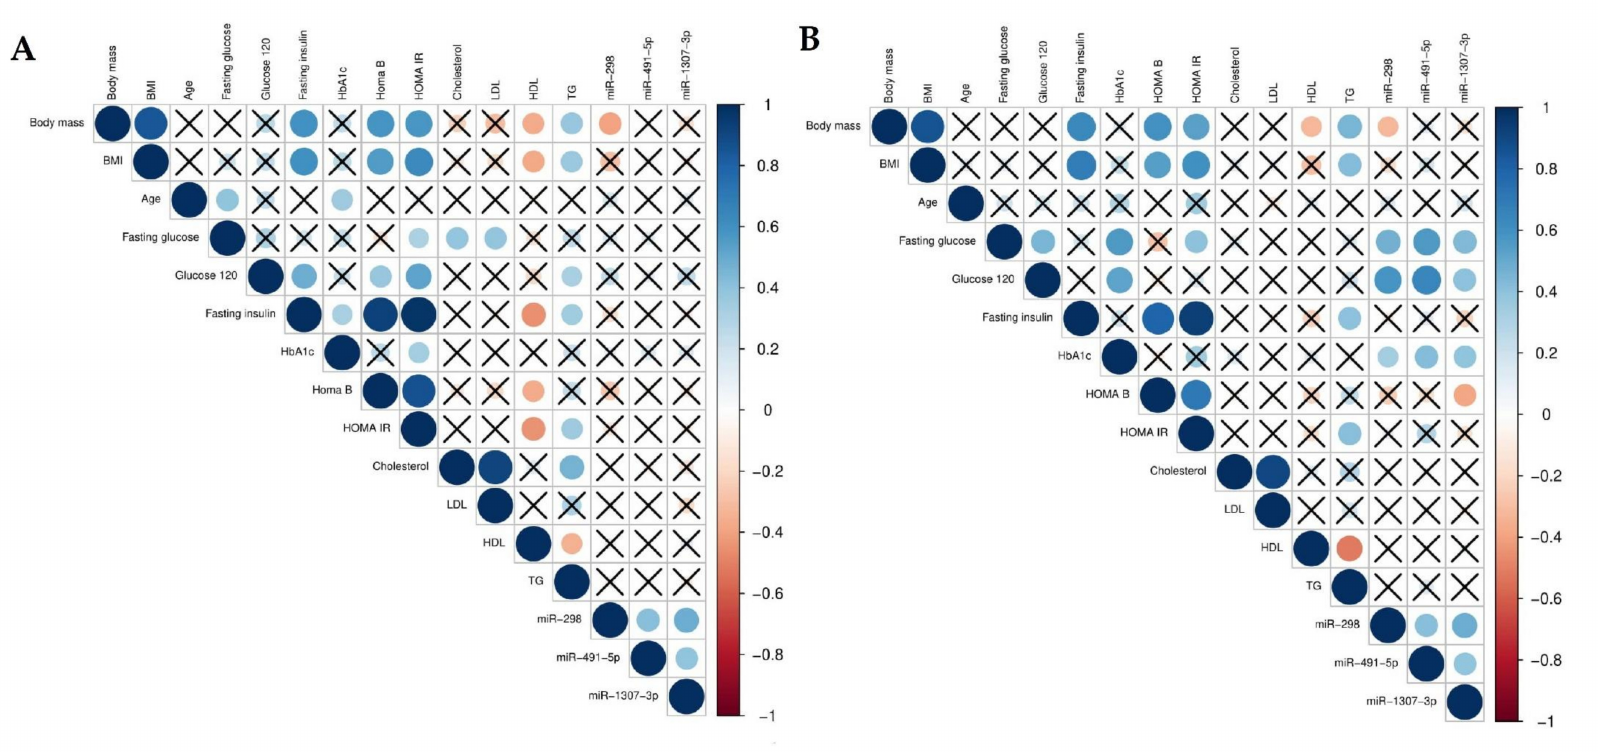
Figure 4. Graphical Spearman correlation matrix of the DE miRNAs (only baseline) and the other measurements on ( A ) visit 1 and ( B ) visit 2. The Spearman correlation r values were determined using R